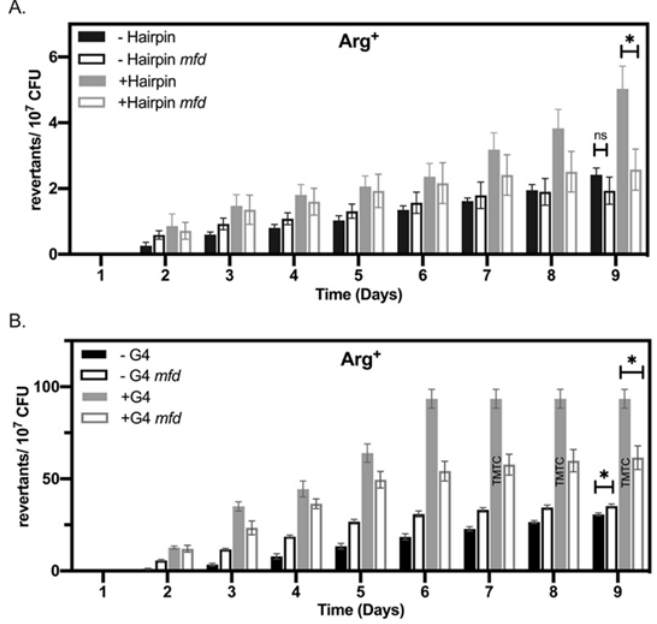
Figure 5. Mfd promotes mutations at hairpin ( A ) and G4 DNA ( B ) forming sequences. Bars represent the mean of at least three SPM trials, and error bars are SEM. Please note the differences in scales on the Y axis between graphs. Significance was determined using a Student’s t -test * p < 0.05.